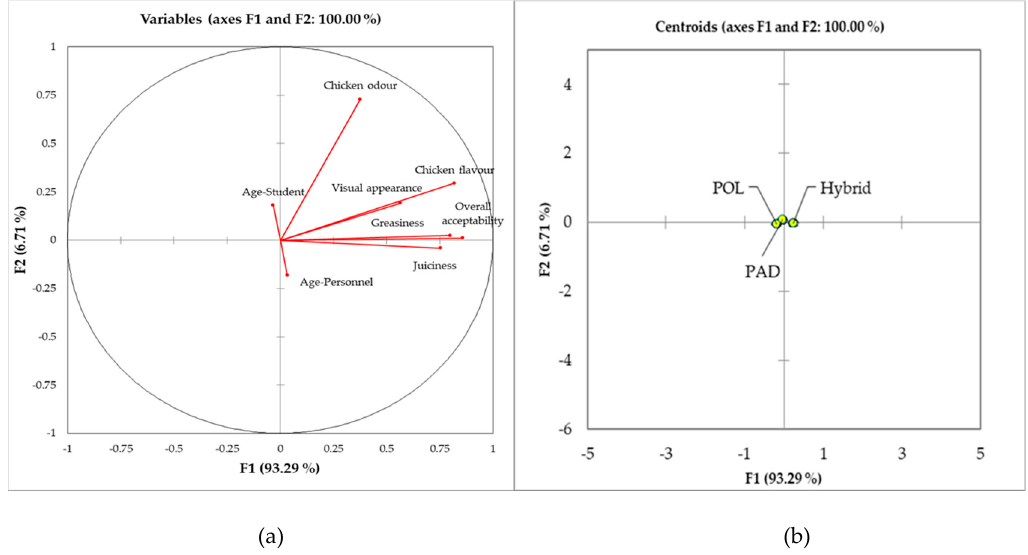
Figure 2. (a,b) Discriminant analysis performed on the sensory data of the consumers’ panel. Hybrid: Hybrid chicken. PAD: Padovana slow-growing breed. POL: Polverara slow-growing breed. Hybrid chicken. PAD: Padovana slow-growing breed. POL: Polverara slow-growing